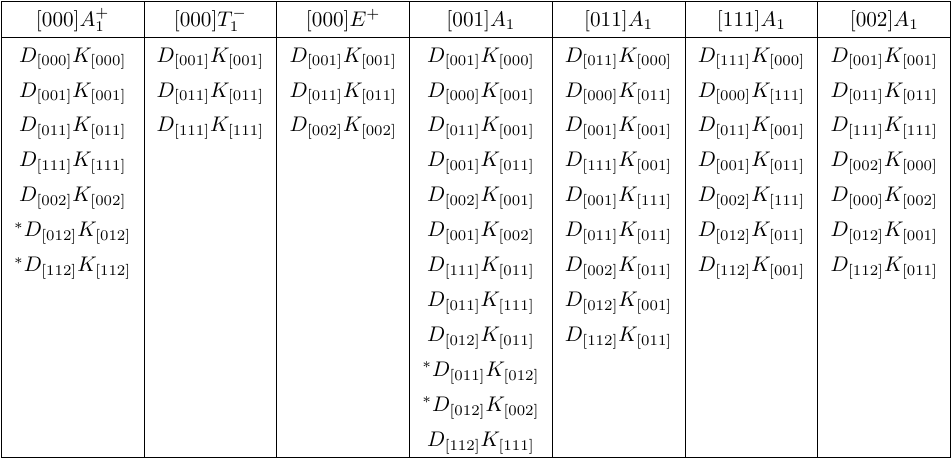
Table 8 . As table 6 but for D ¯ K I = 0 , 1 on the m π = 239 MeV ensemble. The ∗ indicates operators that were only used in the I = 1